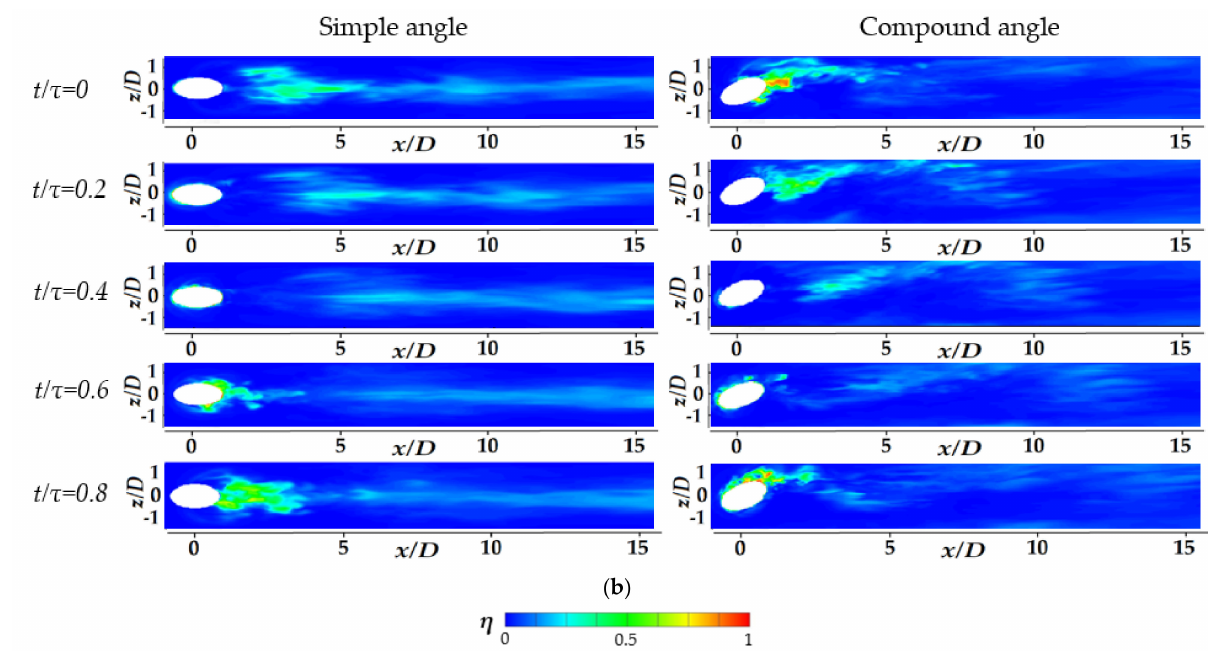
Figure 13. Instantaneous adiabatic film cooling effectiveness distributions for the simple angle and the orientation angle of 30 ◦ . ( a ) For the steady state (0 Hz); ( b ) 36 Hz